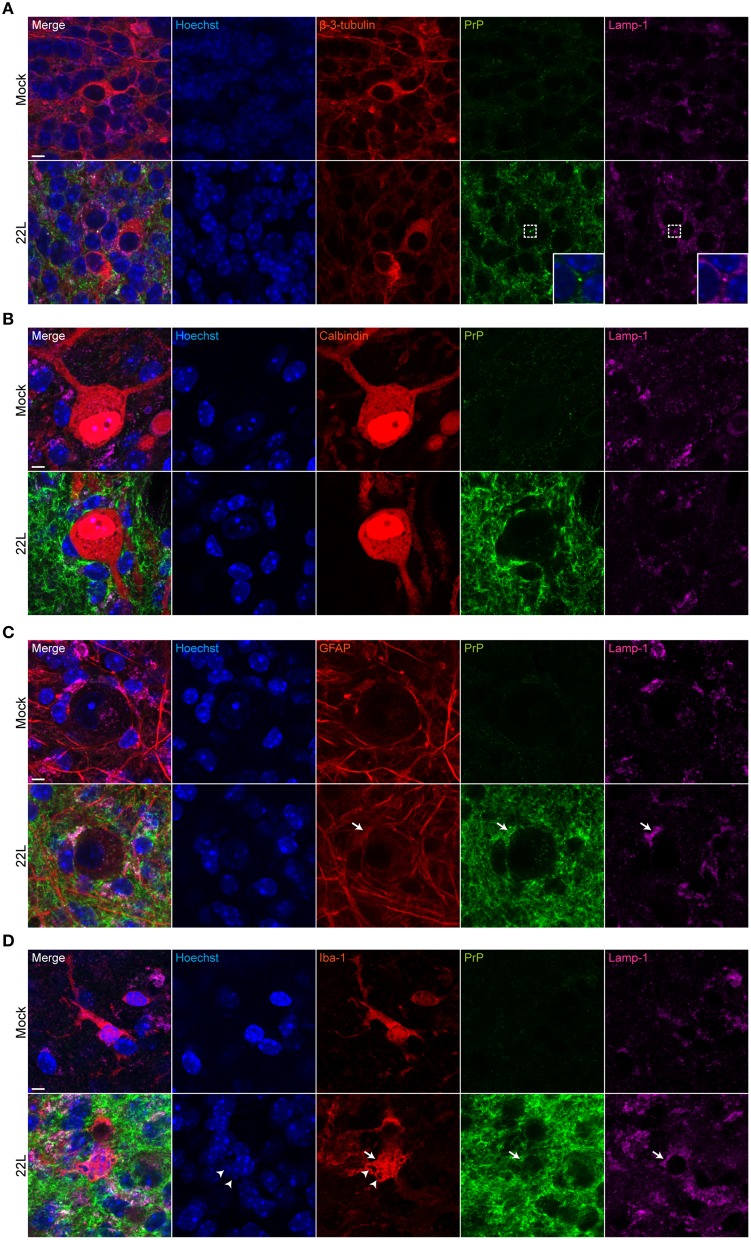
Cellular localization of PrPd in cerebellar slices. 9 weeks p.i., Mock exposed or 22L infected slices were subjected to antigen denaturation and immunofluorescence staining. Cells in the molecular layer of folium IX were analyzed by confocal microscopy using digital zoom with identical imaging settings for each sample group. PrPd was detected with mAb 4H11 (green). (A) Neurons were stained for β-3-tubulin (red). The insets respresent magnifications of the indicated region. (B) Purkinje cells were stained with mAb anti-calbindin (red). (C) Astrocytes were labeled with pAb anti-GFAP (red). Arrows mark co-localization of PrPd with lamp-1 within astrocytes. (D) PAb anti-iba-1 was used to detect microglia (red). Arrowheads mark degenerated nuclei within microglia, arrows mark lysosomes. Lysosomes were labeled with mAb anti-lamp-1 (purple) and nuclei were counterstained with Hoechst. Mock exposed slices served as controls. Scale bar: 5 μm.